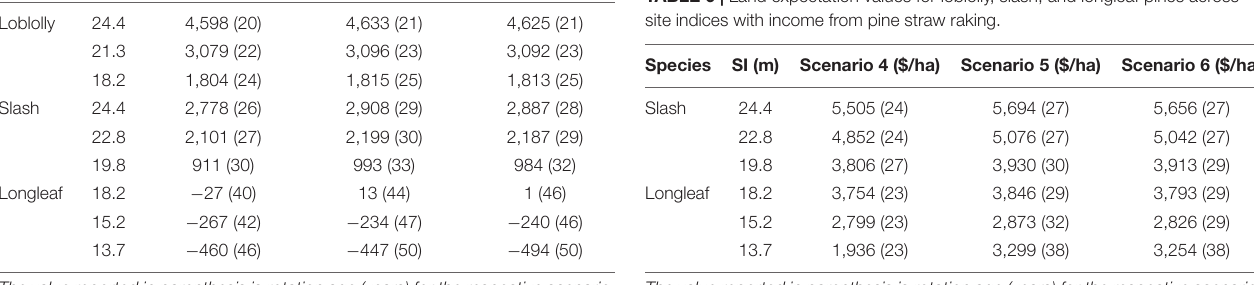
than slash pine, while longleaf pine made a profit of only $1/ha.